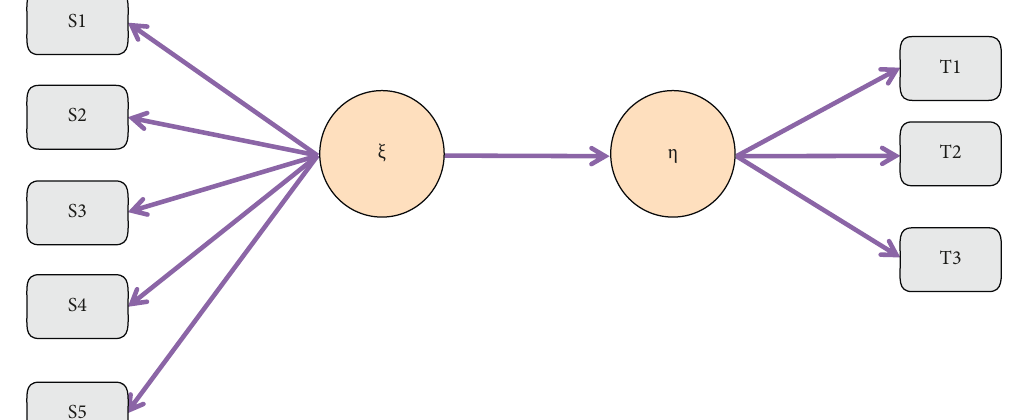
Figure 3: Structural equation model of two latent